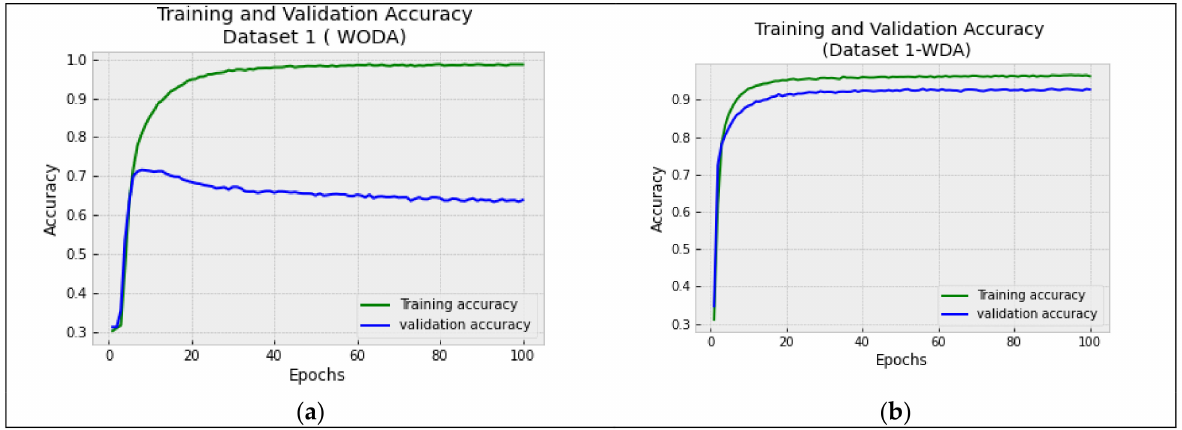
Figure 12. LSTM model validation and testing accuracy and loss dataset 1: ( a ) model accuracy (WODA); ( b ) model accuracy (WDA).